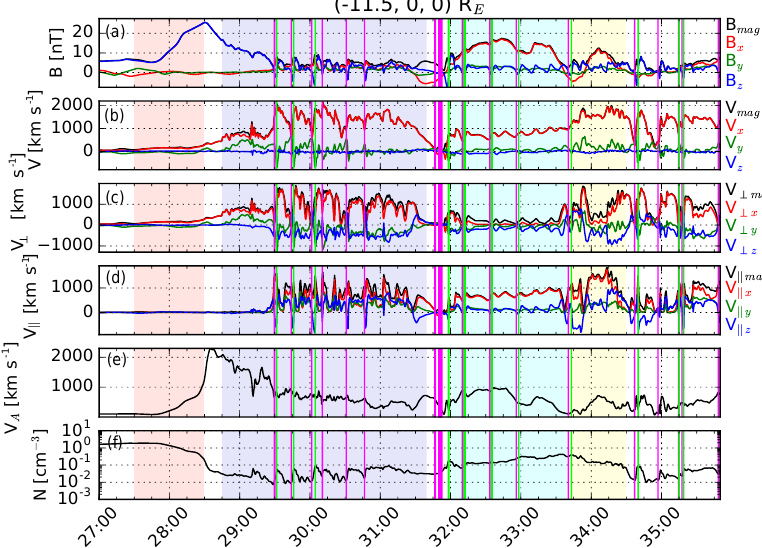
Figure 11. Time series observed by a virtual satellite located at x = − 11 . 5 R E and y = z = 0 in the simulation. From (a) to (f) , the parameters shown are magnetic field, bulk ion velocity, bulk ion velocity perpendicular and parallel to the magnetic field, Alfvén velocity, and ion number density. The passing X and O points are indicated with the magenta and green vertical lines, respectively. Pink shading (27:30– 28:30): dipolarization front. Lavender shading (28:45–31:40): fast earthward flows following the dipolarization front, with embedded X and O points. Cyan shading (32:00–33:40): plasma with enhanced ion density is fed to the plasma sheet from the lobes. Yellow shading (33:40–34:30): faster flows overtake and interact with slower flow in front of them. Note that the time axis is different from the previous